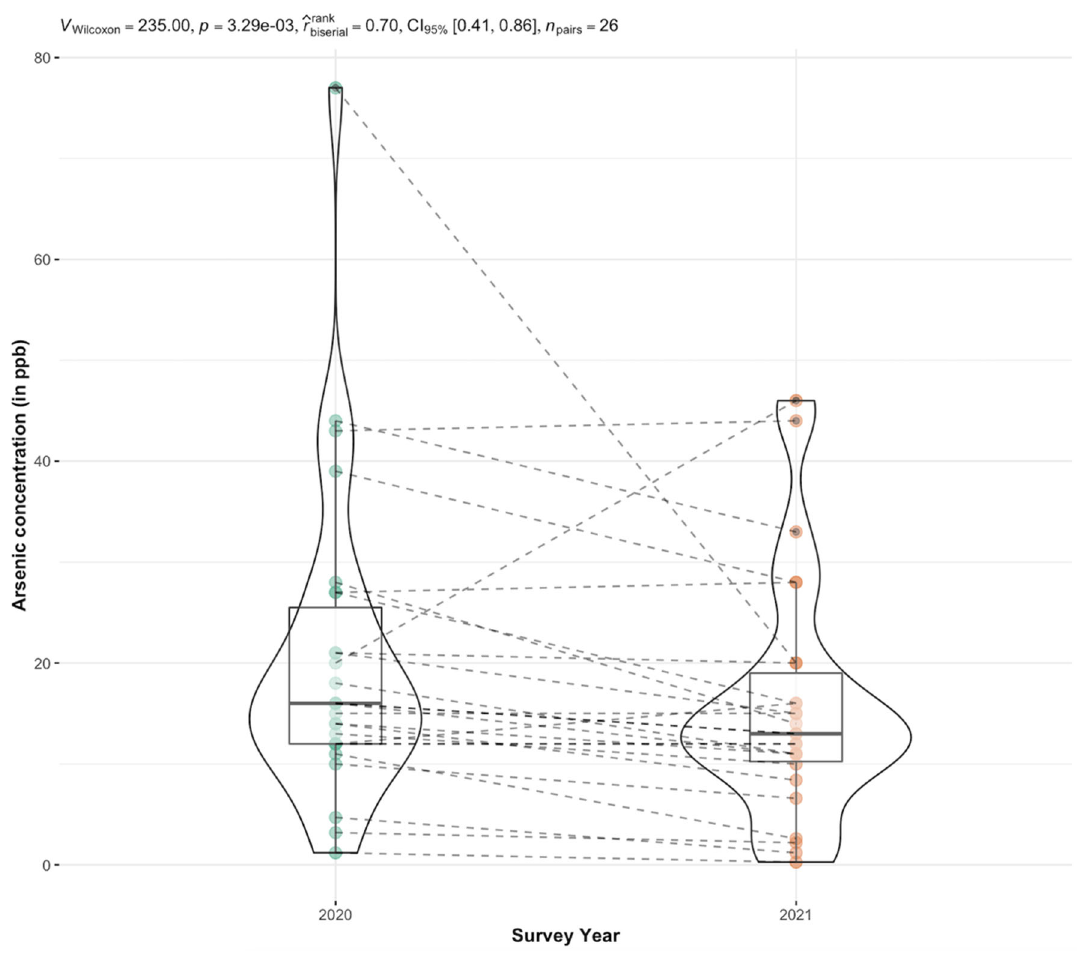
Figure 5. Graphical representation of the paired, two-sample Wilcoxon signed-rank test comparing As levels in selected wells, 2020 vs. 2021. Table 3. Bivariable